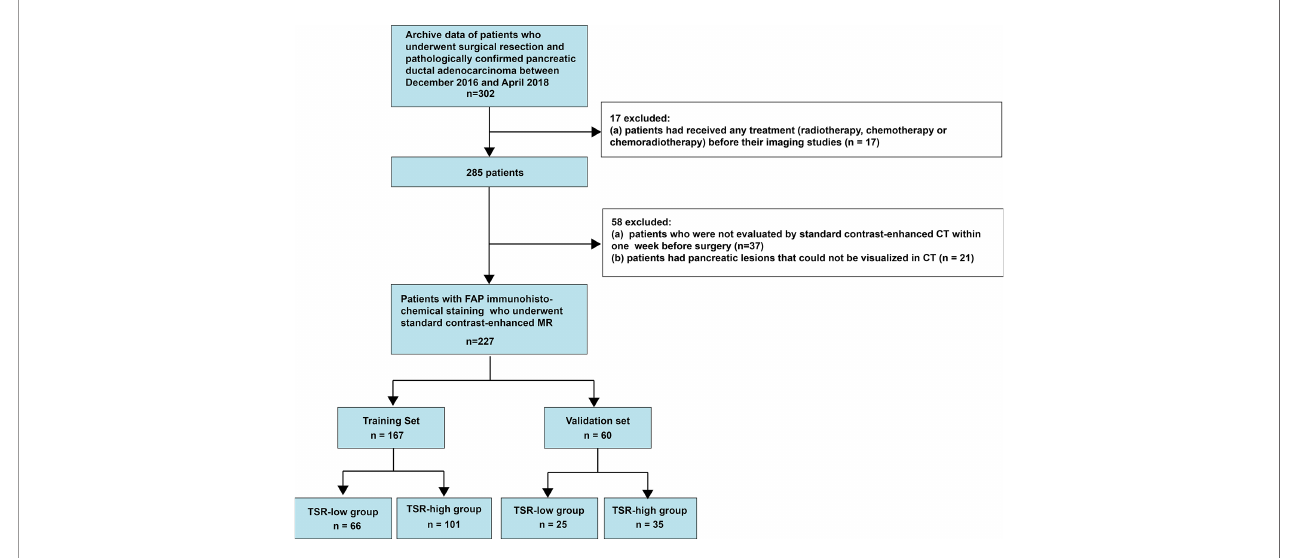
FIGURE 1 | Flow chart illustrating the patient selection